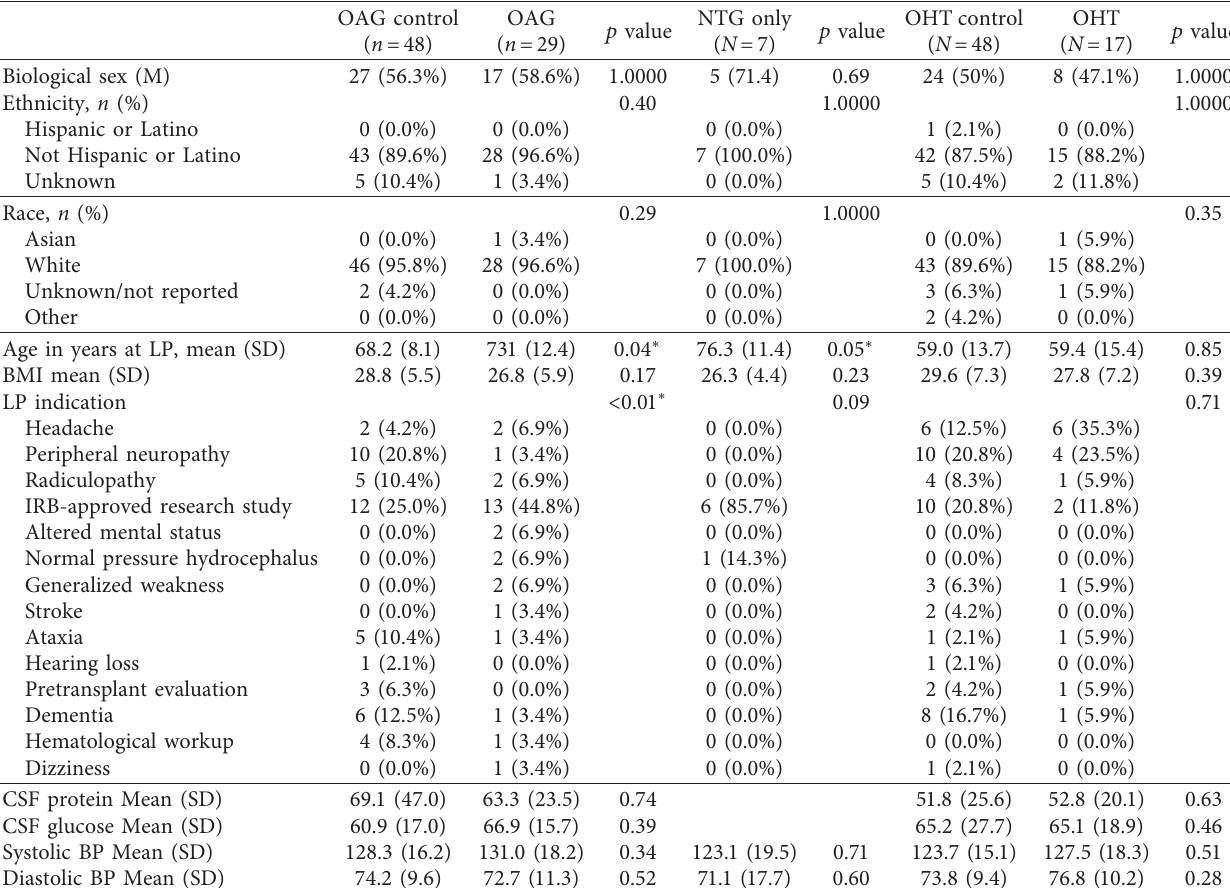
Table 2: Validation of 2007–2019